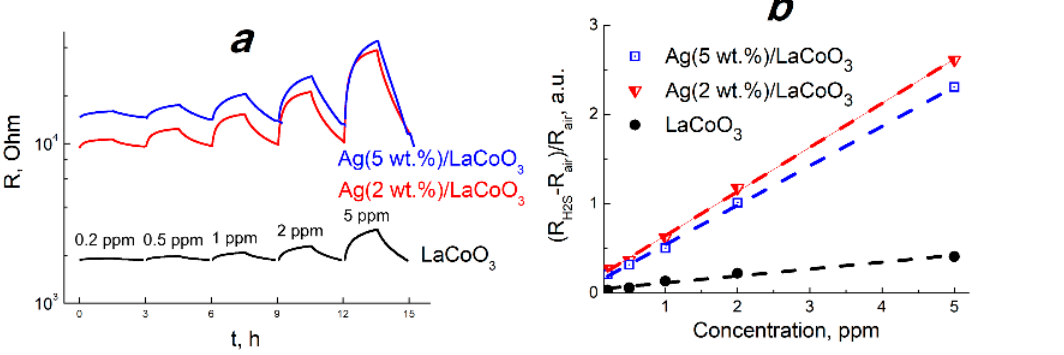
Figure 2. Dynamic response ( a ) and sensor signals ( b ) of LaCoO 3 and Ag/LaCoO 3 to 0.2-5 ppm H 2 S at 200 °C.